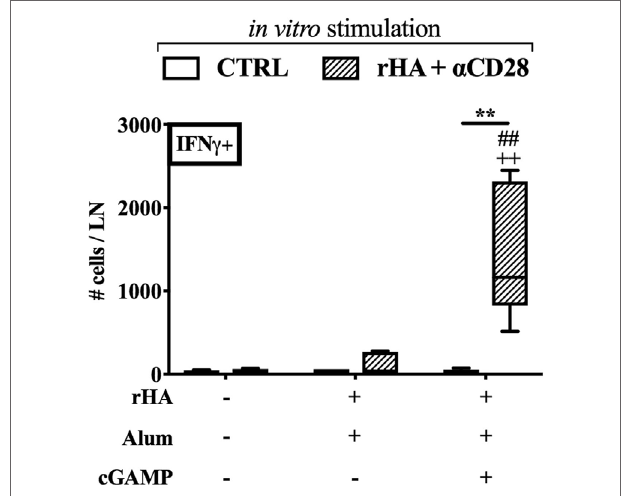
FigUre 4 | Immunization with (cGAMP + alum) induces IFN γ -producing cells in draining lymph nodes (dLNs) of newborn mice. Newborn mice were immunized with alum or (cGAMP + alum) as indicated in Figure 2a . 3 days after boost [day of life (DOL) 17] cells were isolated from dLNs, re-stimulated for 18 h with rHA + α CD28, and the number of IFN γ -producing cells per LN was assessed by ELISPOT. Results are shown as the median, the 25th and 75th percentiles (boxes) and the fifth and 95th percentiles (whiskers) of 4–5 mice per group. ** p < 0.01 of in vitro CTRL vs. rHA + α CD28, ++ p < 0.01 of respective in vitro conditions compared to in vivo saline group, ## p < 0.01 of respective in vitro conditions compared to in vivo alum group, determined by two-way ANOVA with Sidak’s post hoc